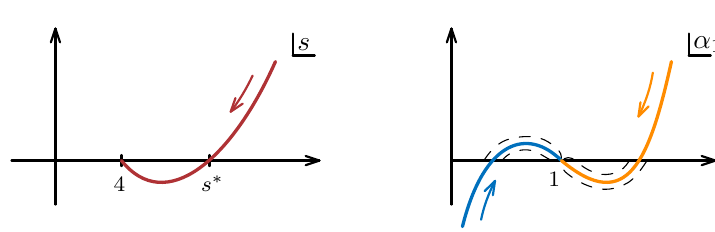
Figure 8. Illustration of Ex. 23. Left: trajectory of the parameter s (in red) and the real axis. The end point of the trajectory is s = 4 . Right: corresponding trajectories of the two solutions of F = 0 in the complex α 1 -plane, one in blue and one in orange. The black line represents the B 2 positive real axis. The dashed lines show a possible deformation of the integration contour as the blue and orange trajectories approach each other at α 1 = 1